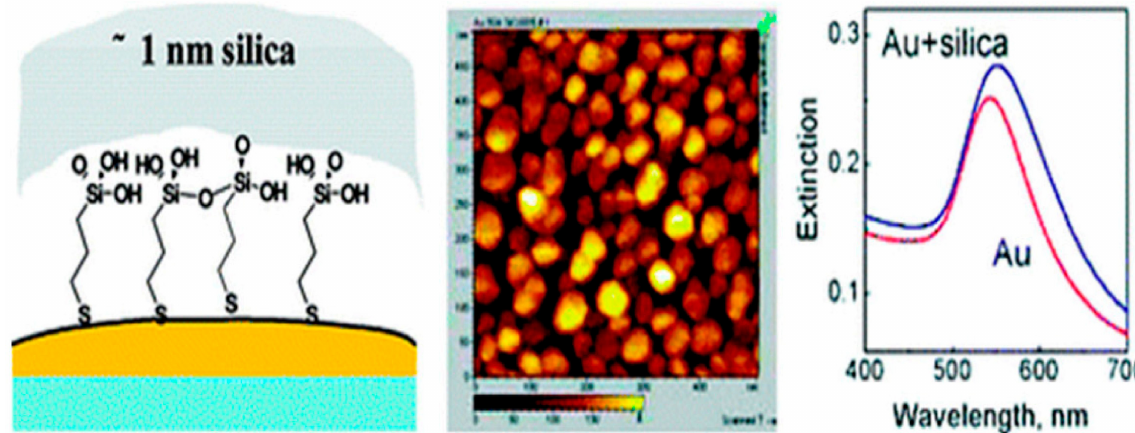
Figure 6. Schematic of coating Au NPs by means of SiO 2 by a mercaptosilane group, using the Au/SiO 2 core/shell picture and UV-vis spectra. Reproduced by reference authorisation, ACS, 2007 [69].